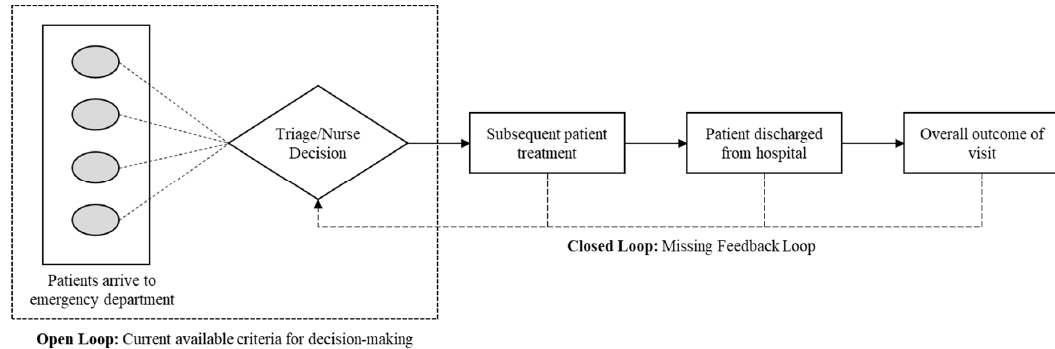
Figure 2. US Emergency department feedback loop.